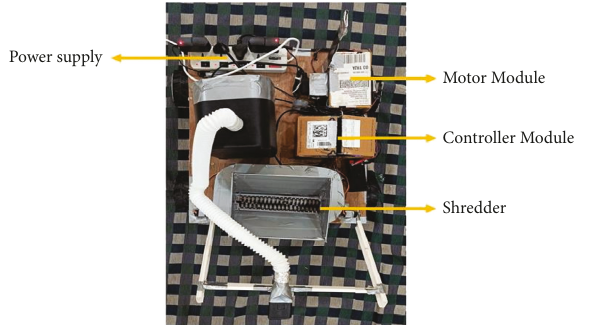
Figure 7: Shredder pickup path.